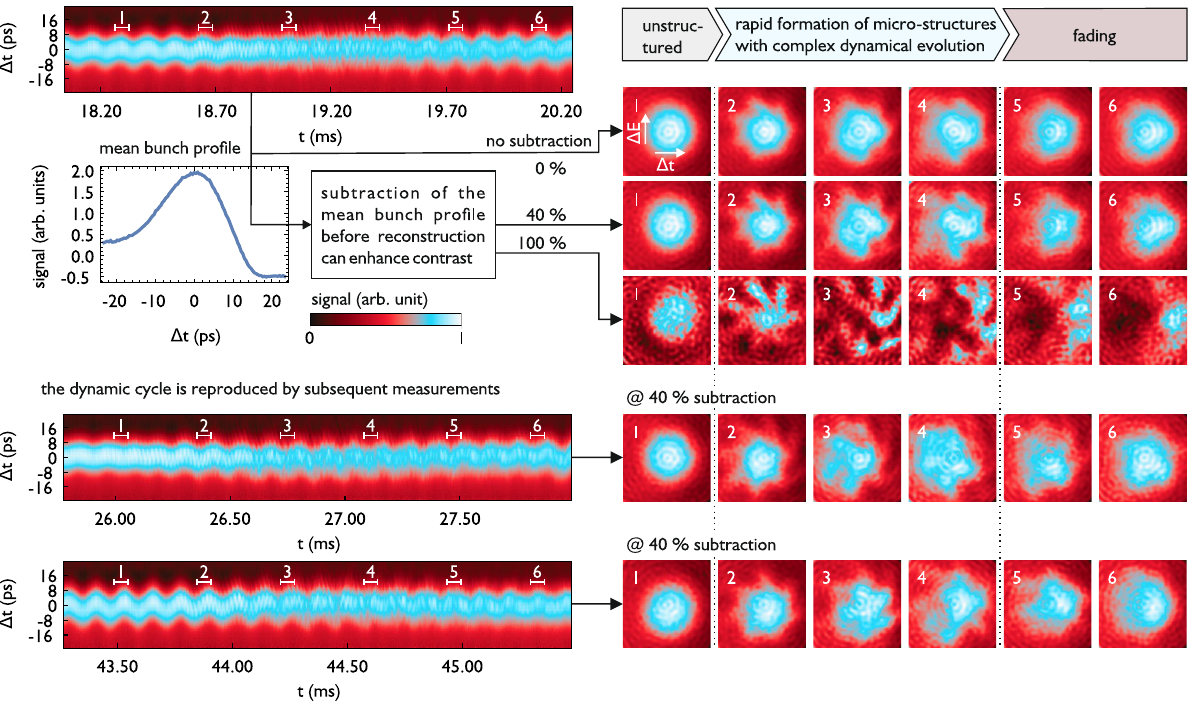
Figure 3. Experimental data: ( a ) Three revolution plots of 6000 consecutive measurements (corresponding to 18 synchrotron oscillations) of the electron bunch charge density taken from a longer data set with 500,000 measurements ( ∼ 0.18 s). For each revolution plot, the measurements are concatenated from left to right. The value for (cid:31) t is determined by the pixel number of the line array, calibration measurements 39 and the mean bunch profile position. ( b ) Corresponding reconstructions of the PSD for different time intervals. The numbers refer to the time intervals marked in the revolution plots on the left side, respectively. Upper side: reconstructions for different subtraction percentages of the mean bunch profile are compared for the first revolution plot. The dynamic cycle of the microbunching instability is repeated over and over again, as it can be seen by comparing the rows of the reconstructed PSDs for the different revolution plots. In the supplement, we provide an animation of the PSD development, which is derived from the first revolution plot. To provide the optimal contrast, we normalized the data for every image independently. The color scale of the present and previous Fig. was calculated from a data set provided by P Kovesi 41,42 . An independent calculated gray scale image is provided by the supplementary Fig.